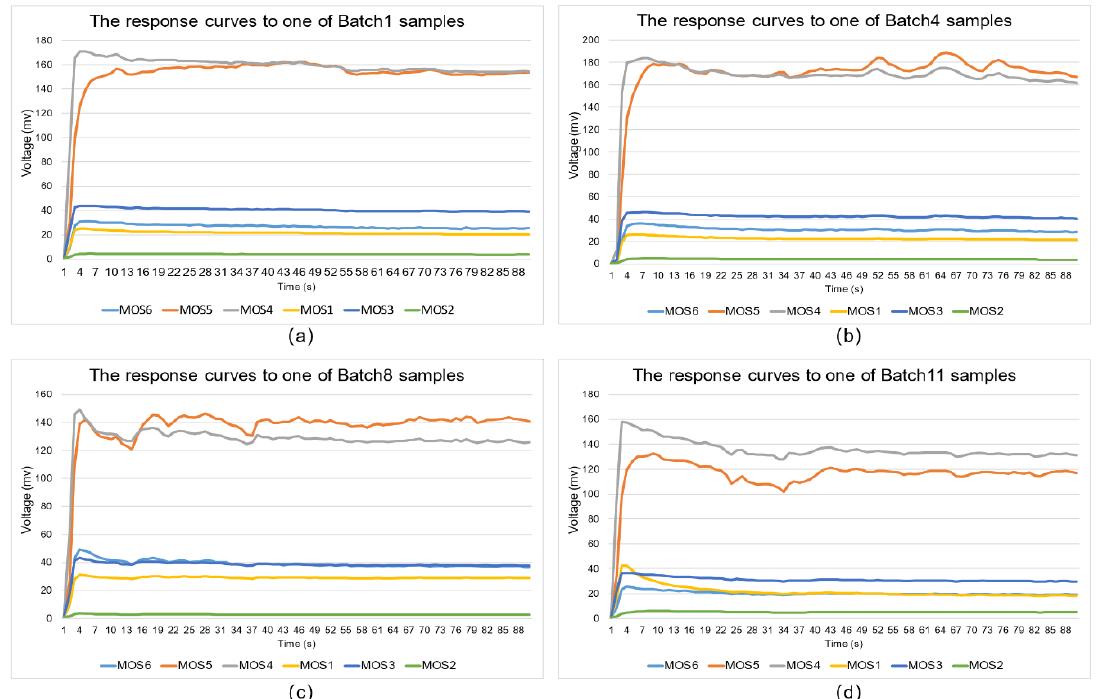
Figure 4. Response curves to data from different batches: ( a ) Batch 1; ( b ) Batch 4; ( c ) Batch 8; ( d ) Batch 11.